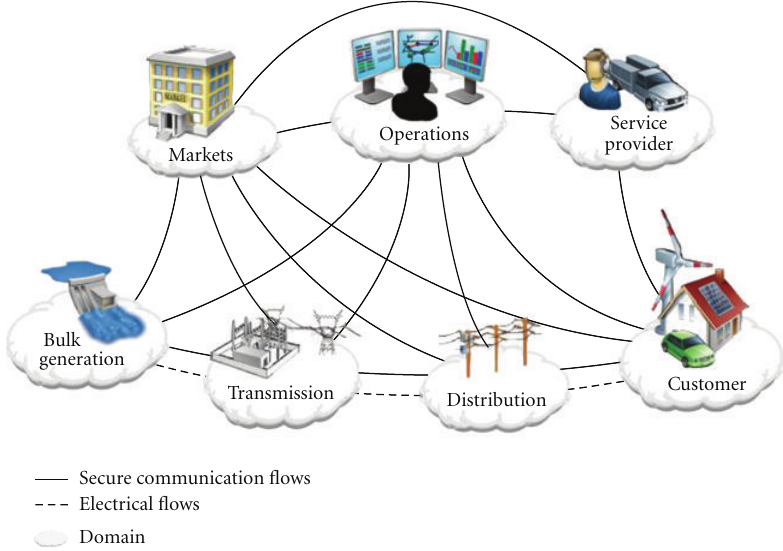
Figure 2: Interaction among actors in smart grid domains through secure communication flows and flows of electricity.